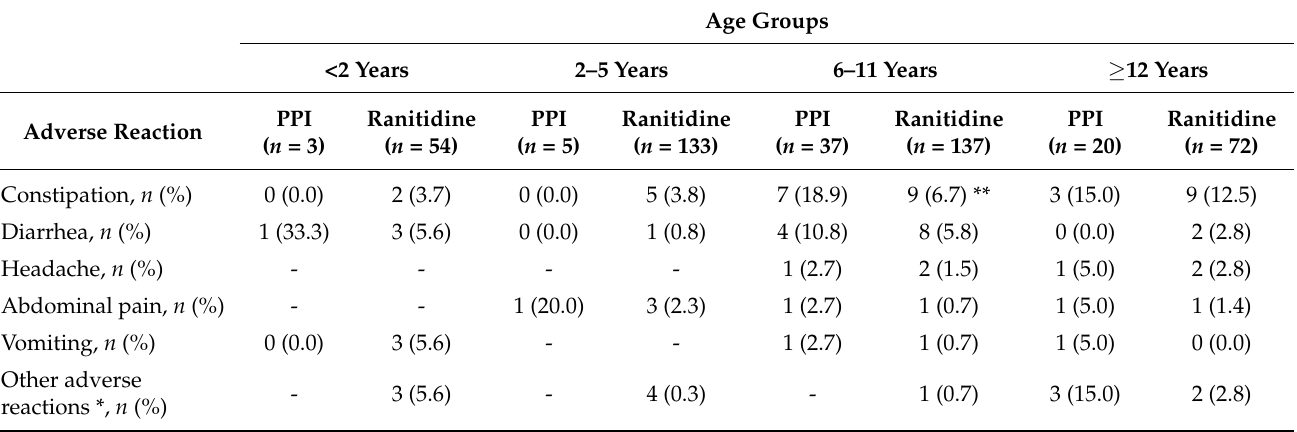
Table 4. Adverse drug reactions observed in the study population, stratified by age group and treatment